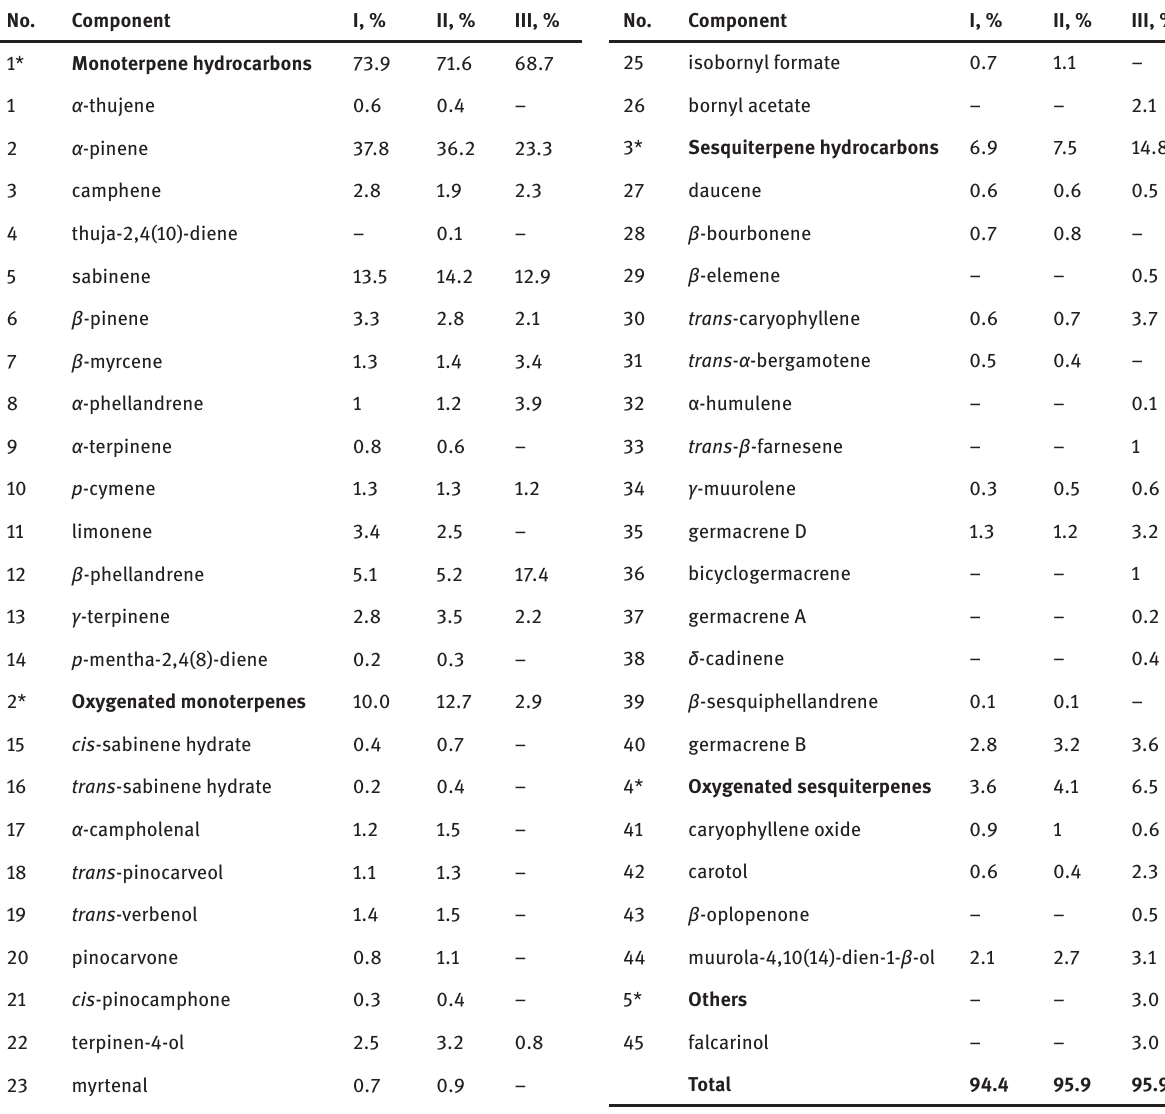
1: Essential oil composition of S. rigidum collected in: control area (I); post fire area (II); another geographical location (III- Marcetic et al. ,